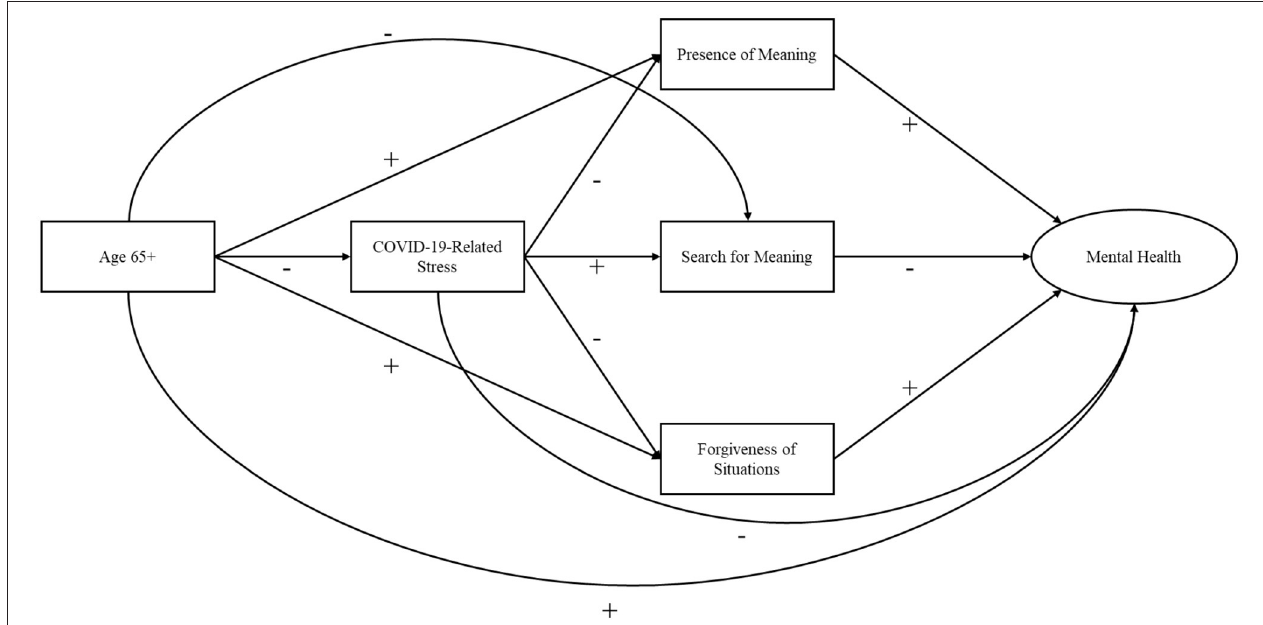
FIGURE 1 | Hypothesized structural model. + and – indicate predicted positive and negative